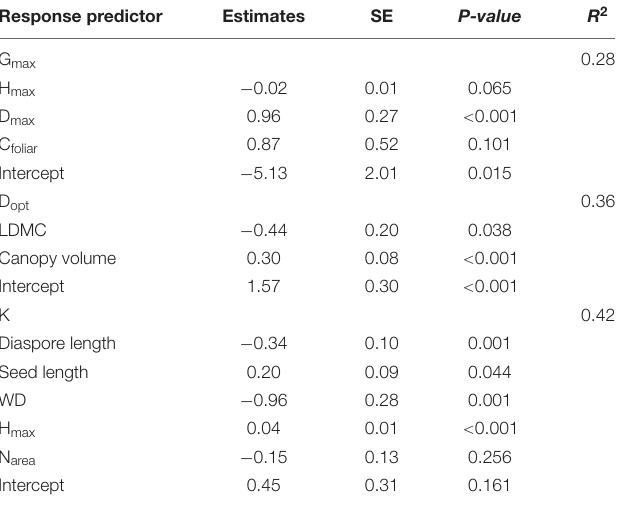
TABLE 1 | Estimated coefficients, adjusted intervals and P-values for each of the best model predictors for maximum growth rate (G max ), diameter at maximum growth rate (D opt ), and the ontogenetic variability in growth rate (K). Full model correlation coefficients ( R 2 ) are also shown. All models were significant at P < 0.001. Abbreviations as follow: maximum height (H max ), maximum diameter